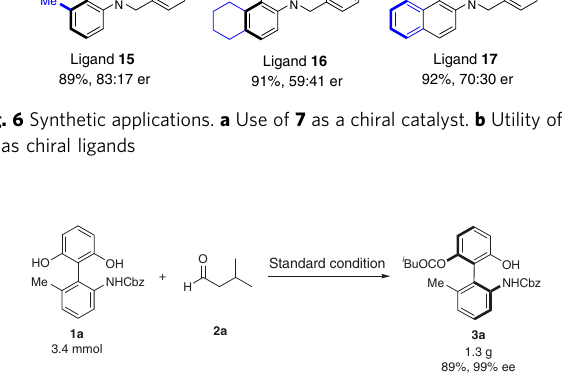
Fig. 7 Gram-scale synthesis. Reaction conditions: a mixture of 1a (3.4 mmol, 1.19 g), 2a (5.1 mmol, 0.55 mL), in CH 2 Cl 2 (34.0 mL) was